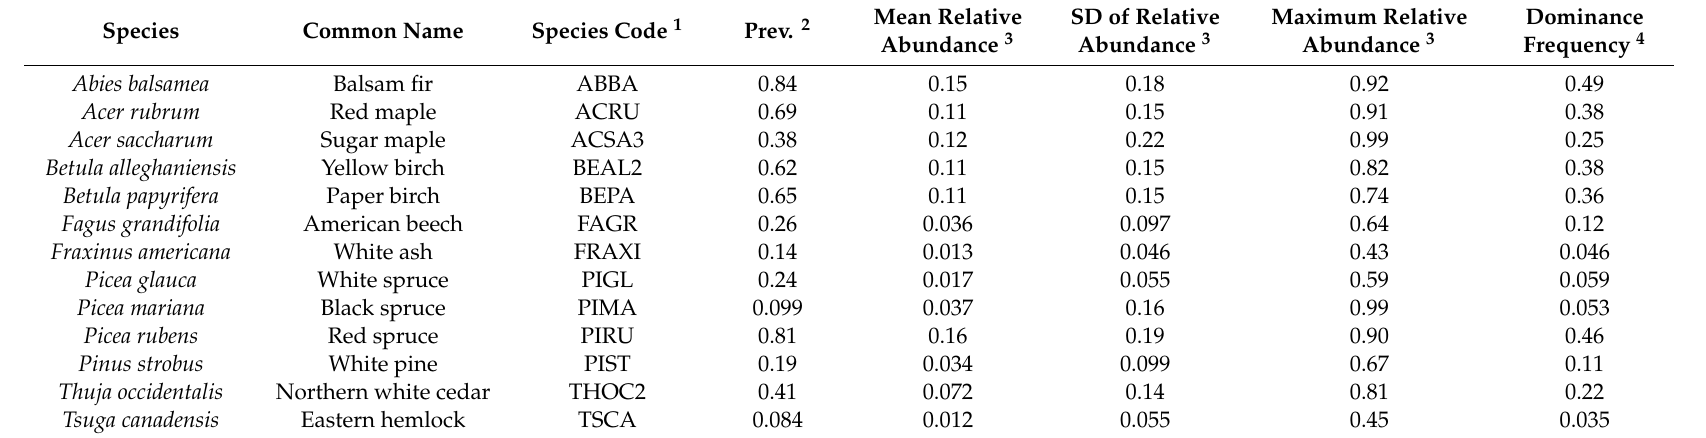
Table 3. Reference data characteristics of the 13 modeled tree species (349